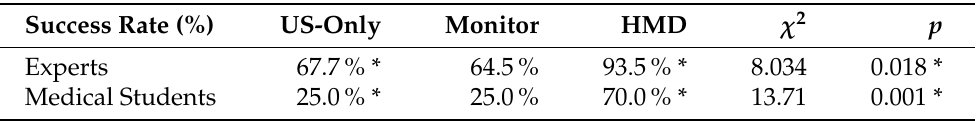
Table 3. Summary of the success rates by system and the associated statistics. Systems with significant differences in success rates ( p < 0.05) are denoted with